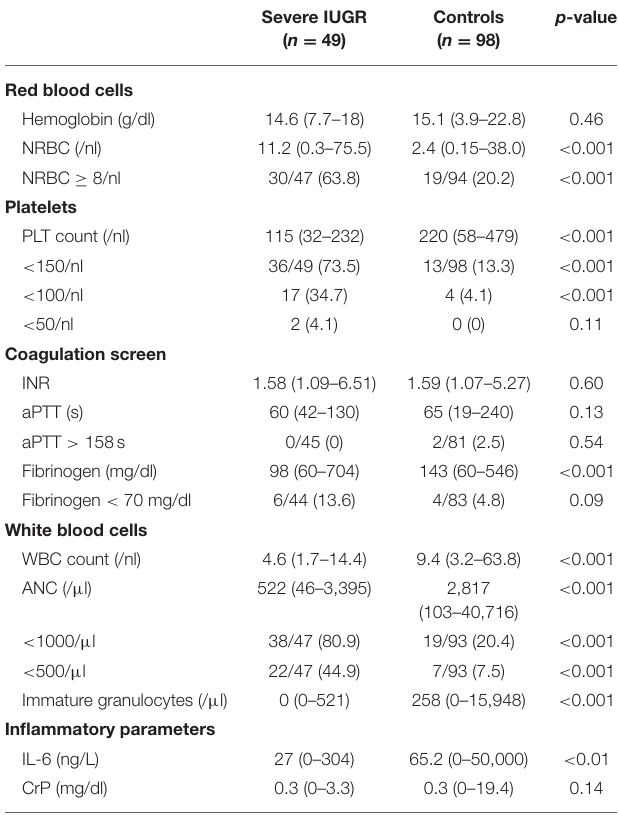
TABLE 2 | Blood cell counts, coagulation screens, and inflammatory markers on